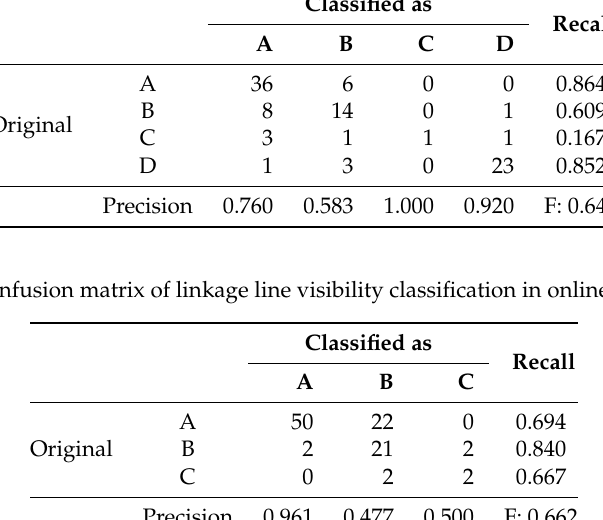
Classified as Recall A B C D